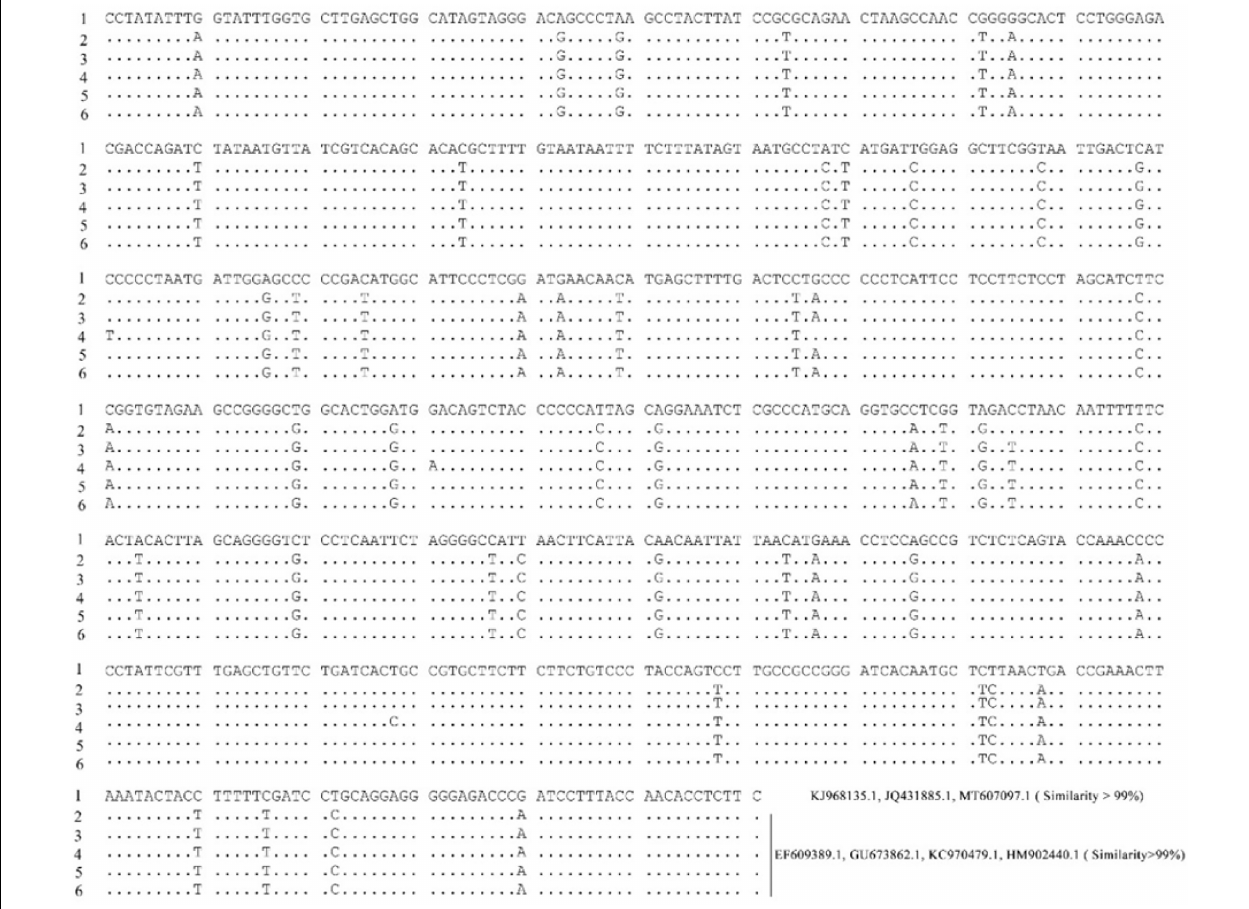
Frontiers in Marine Science |